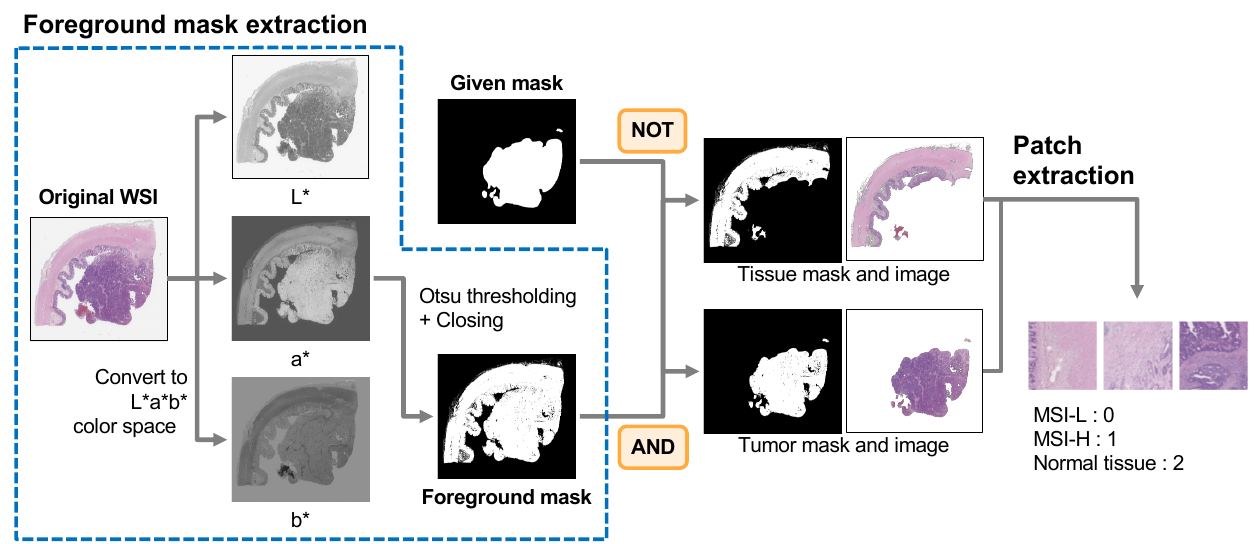
Figure 1. Overview of the patch preparation procedure: foreground mask extraction, new tissue and mask creation, and patch extraction.